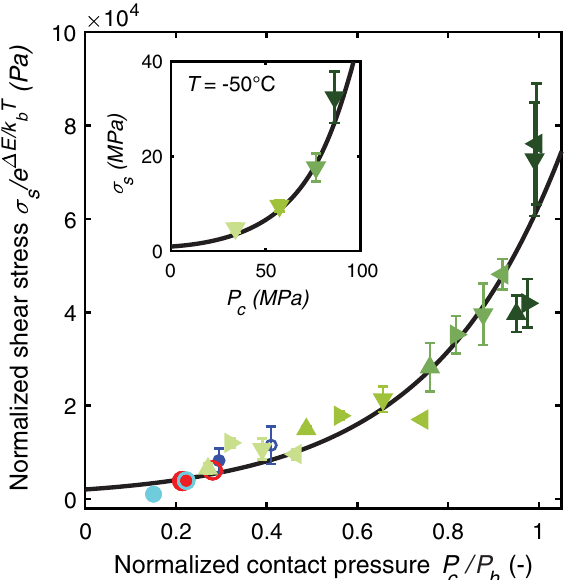
FIG. 4. Normalized shear stress σ s =e Δ E=k B T as a function of the normalized contact pressure P c =P h for various sliders, surface roughnesses, and temperatures at a sliding speed of 0 . 38 mm = s. The solid line is a fit using Eq. (5). Triangles from light green to dark green correspond to glass spheres with a surface roughness S q of 98, 222, 575, and 3077 nm, where upward, right, down, and left-pointing triangles are measurements at T ¼ − 90 °C, − 70 °C, − 50 °C, and − 30 °C, respectively. The blue, red, and cyan circles correspond to, respectively, a small SiC ( R ¼ 0 . 75 mm), a large SiC ( R ¼ 6 mm), and a sapphire sphere ( R ¼ 1 . 59 mm) at T ¼ − 90 °C for closed and − 50 °C for open markers. The error bars represent the standard deviation in the measured friction force. Inset: shear stress as a function of the contact pressure for various glass sliders with increasing surface roughness at T ¼ − 50 °C and a sliding speed of 0 . 38 mm =